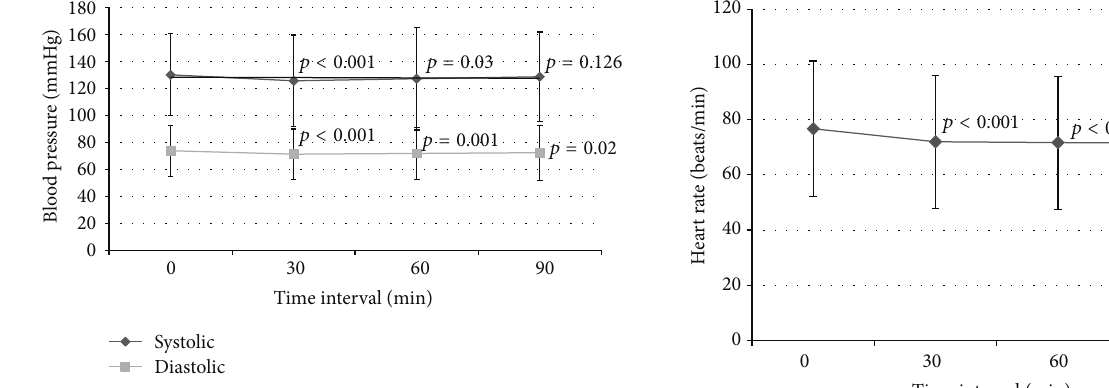
Figure 1: Systolic and diastolic blood pressure over time. Signifi- cance value pairwise comparison for SBP (paired 𝑡 -test): 𝑝 < 0.001 for 0min versus 30 min, 𝑝 = 0.03 for 0min versus 60 min, and 𝑝 = 0.126 for 0 min versus 90 min. Significance value pairwise comparison for DBP (paired 𝑡 -test): 𝑝 < 0.001 for 0 min versus 30 min, 𝑝 = 0.001 for 0 min versus 60min, and 𝑝 = 0.02 for 0 min versus 90 min.